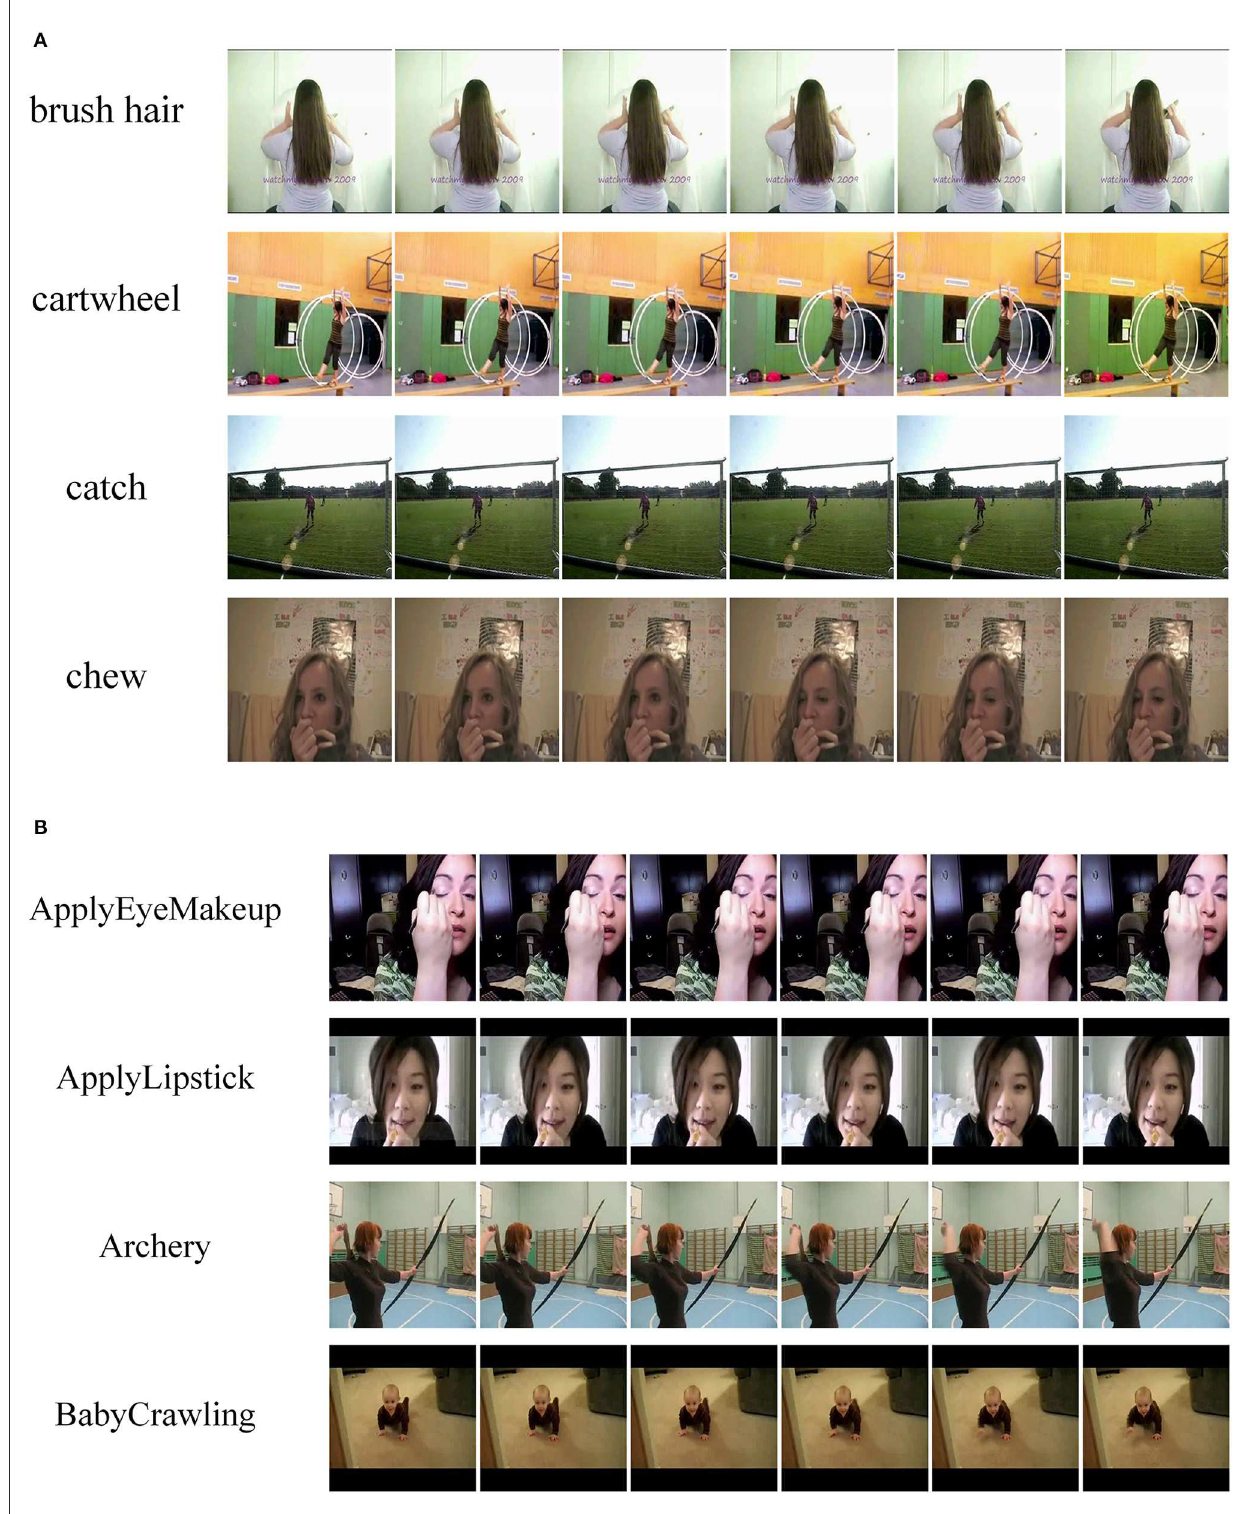
FIGURE3 (A) HMDB51 dataset. (B) UCF101 dataset.